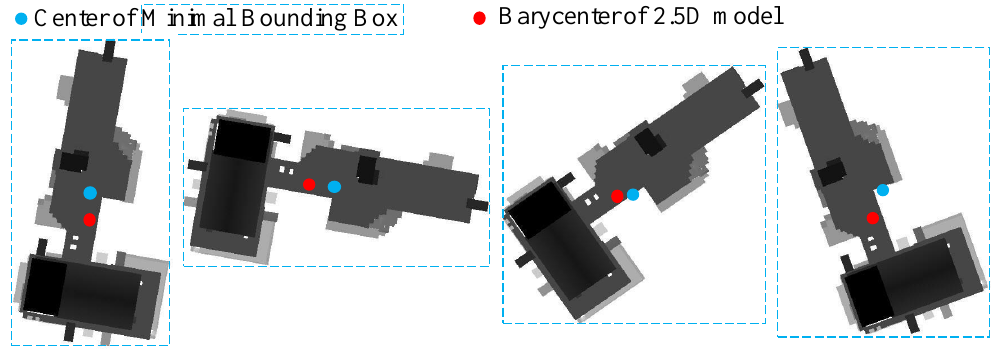
Figure 3. Comparisons between the origins obtained by using the minimal bounding box (the cyan dots) and the building volume (the red